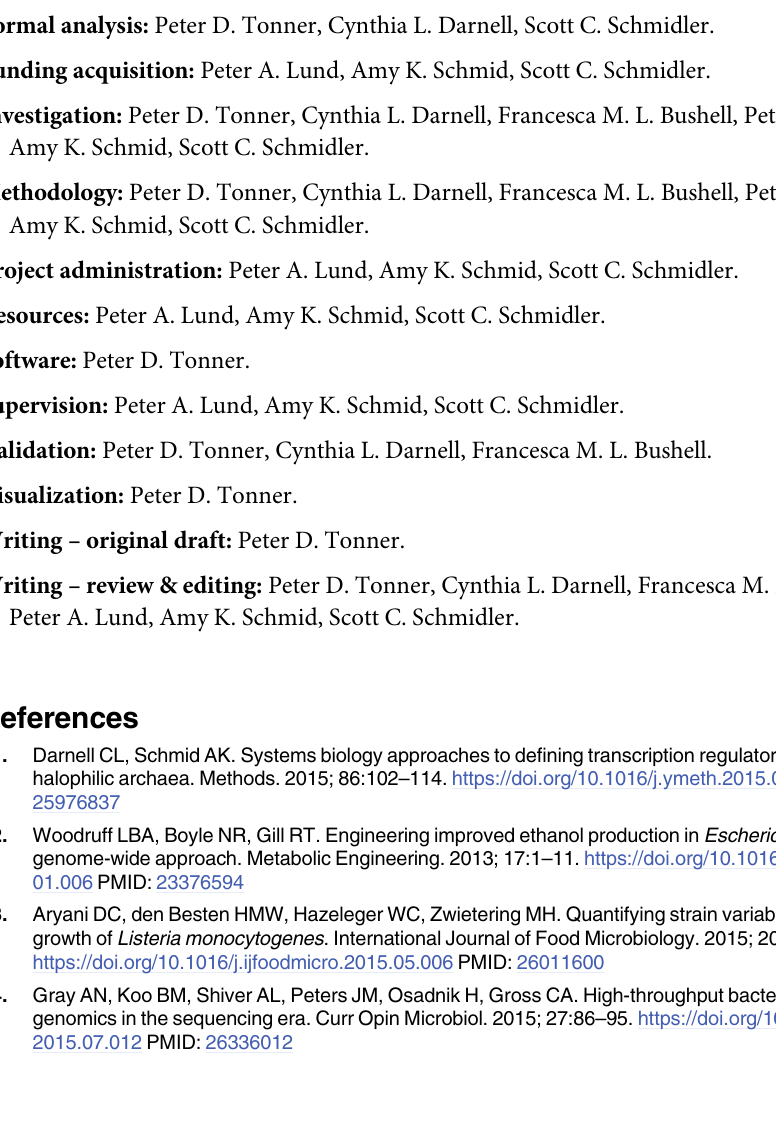
S8 Fig. Posterior intervals of interactions for P. aeruginosa on an absolute growth scale. Posterior intervals of interactions in Fig 5B, but reported here on an absolute (log OD) scale. The same data is reported on the derivative (d log OD / dt) scale in the main text Fig 5B. (EPS) S9 Fig. Posterior variance of function estimates under different models. Each plot shows the posterior variance of a function at each time point under each of M M . (A) δ ( t ) estimated for H. salinarum growth under low (left) and high (right) OS. (B) null ( αβ ) ( t ) at pH = 5, mM malic acid = p , c